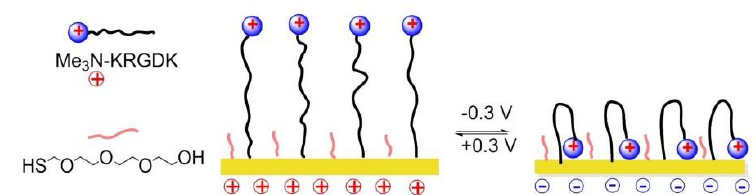
Figure 19. Potential responsive polymers on the Au surface. When the surface is positively charged, positively charged RGD-containing molecule (Me 3 N + )-KRGDK is extended, and the RGD peptide is exposed and active. When the surfaced is negatively charged, (Me 3 N + )-KRGDK is hidden.